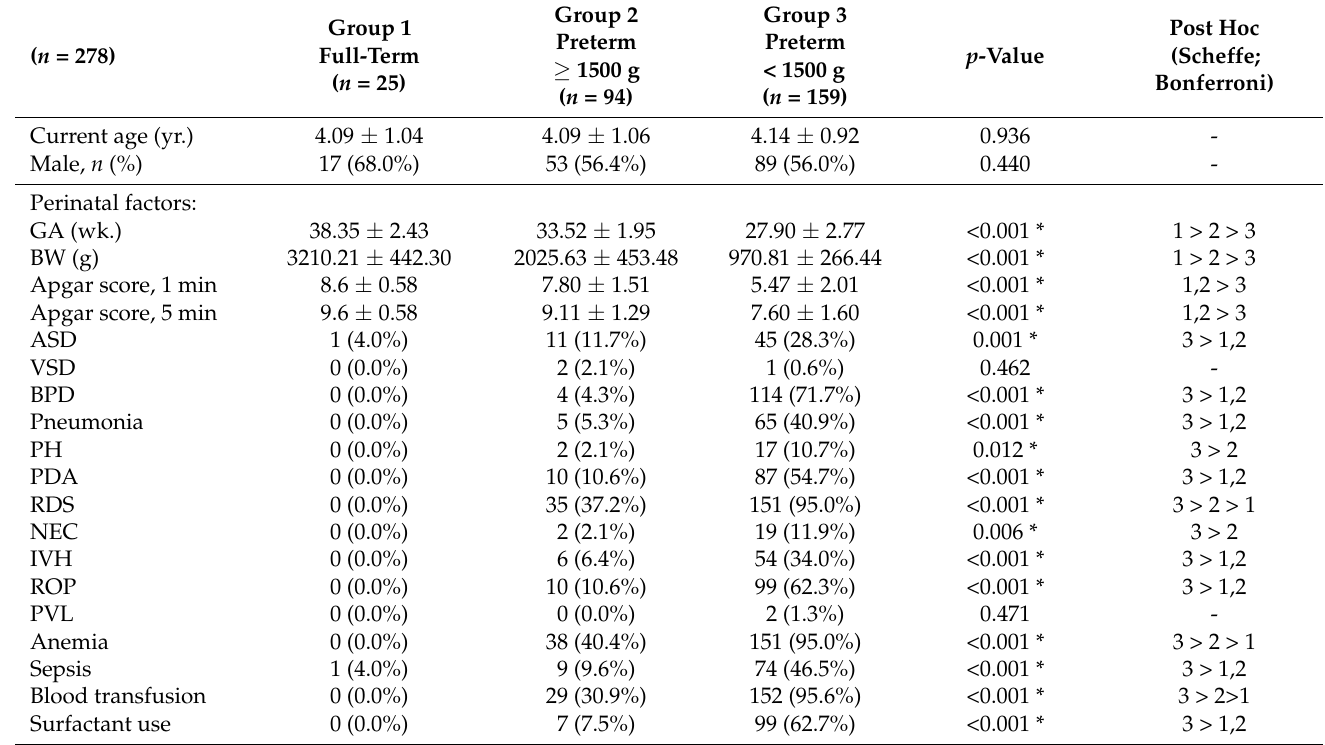
Table 1. Demographic and clinical data of all participants ( n = 278).